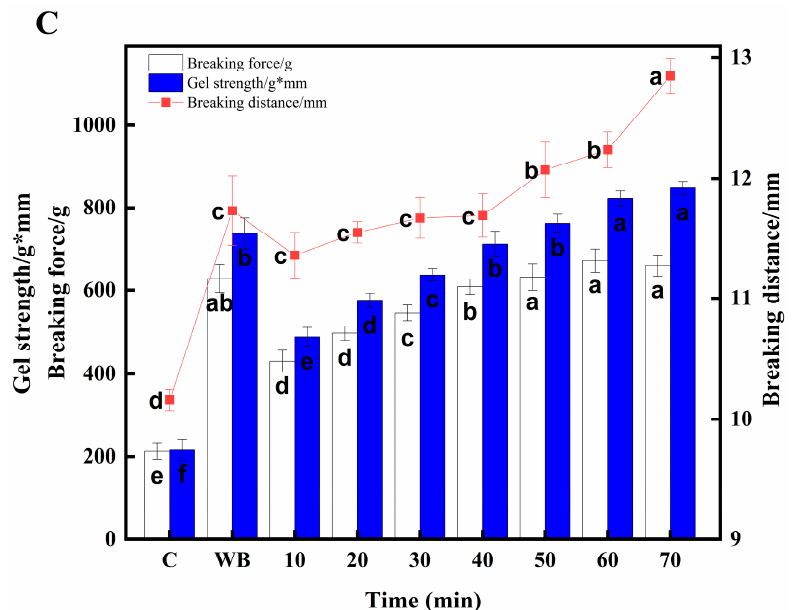
Figure 7. Effect of different DPCD treatments on the surimi gel strength ( A ): Pressure, ( B ): Temperature, ( C ): Time. Different letters indicate statistically significant differences ( p < 0.05).